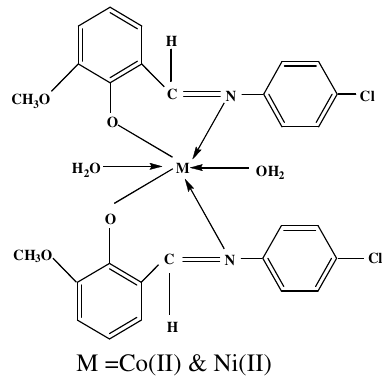
Figure 2. Structures of the complexes